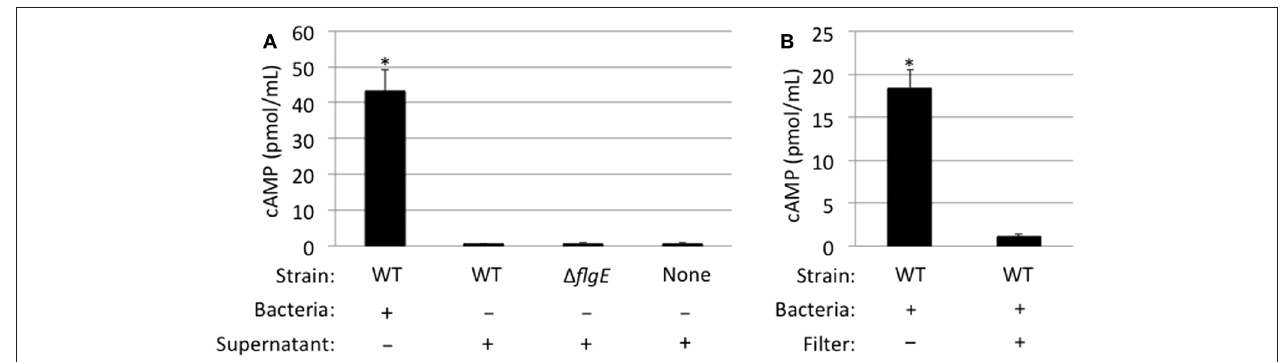
FIGURE 6 | CiaC-ACD delivery into INT 407 cells requires bacteria-host cell contact. The delivery of CiaC-ACD into INT 407 cells assayed using whole bacteria and CiaC-ACD containing supernatants (A) , as well as a filter to block physical contact of bacteria with INT 407 cells (B) . (A) Cell-free supernatants of C. jejuni F38011 wild-type strain and isogenic flgE mutant were harvested from bacteria incubated in MEM supplemented with 1% FBS for 1h. The C. jejuni F38011strain harboring the ciaC-ACD plasmid or cell-free supernatants collected from this strain were added to INT 407 cells and cAMP was measured 30min post-inoculation. (B) A delivery assay